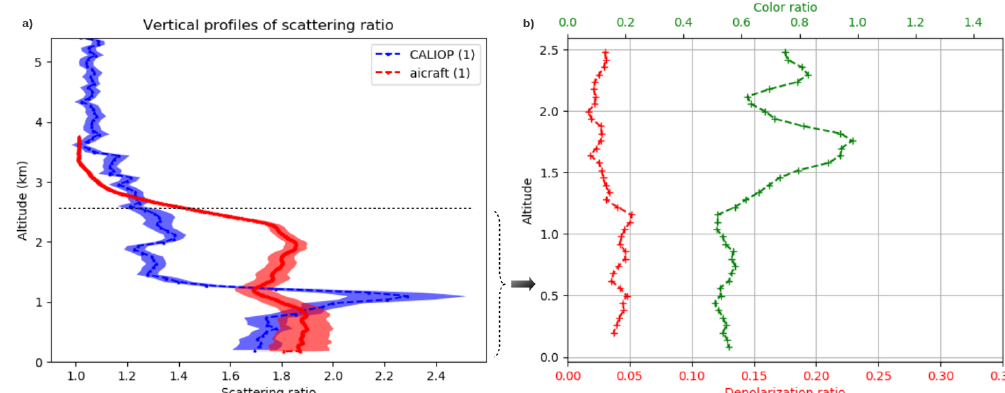
Figure 6. ( a ) Vertical profiles of 532 nm backscatter ratio for the aircraft lidar in red box of Figure 3a (red line) and for CALIOP on 15 June 2017 at 21 UT and 54 ◦ N, 75 ◦ E. (blue line), ( b ) Vertical profiles of the particle color ratio (green) and particle linear depolarization ratio (red) measured by